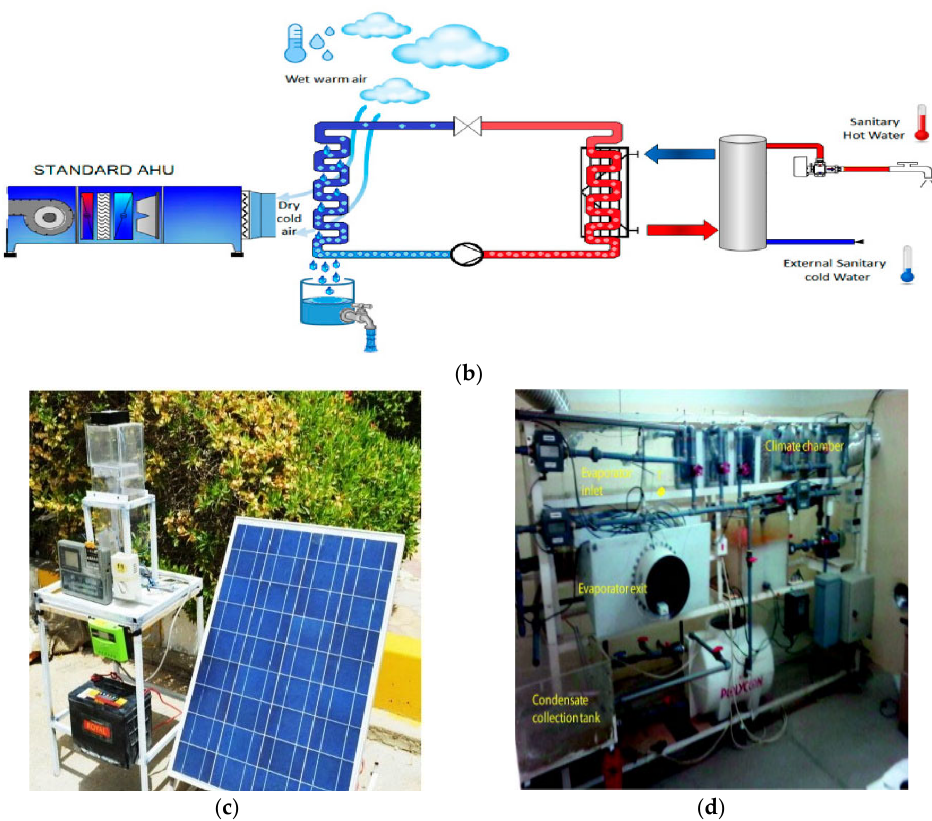
Figure 5. Various types of fog water harvesting. ( a ) Combining air conditioning and drinking water production into a single integrated system [124]. ( b ) Collecting water from the air using refrigeration techniques [127]. ( c ) Harvesting water from the atmosphere using solar energy and the Peltier effect [129]. ( d ) Extracting water from the condensation produced by vapor compression systems in hot and humid regions as a source of water [117].